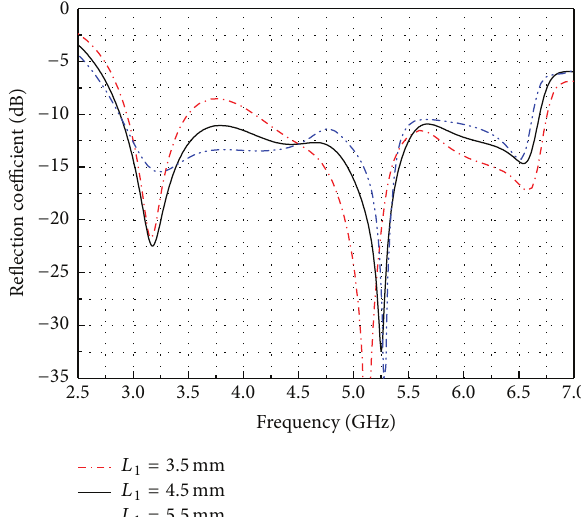
Figure 8: Simulated reflection coefficient with different values of 𝜀 𝑟 ( 𝑑 1 = 23.0 mm, 𝑑 2 = 3.0 mm, ℎ 1 = 6.0 mm, ℎ 2 = 15.0 mm, ℎ 3 = 10.0 mm, 𝑊 2.5